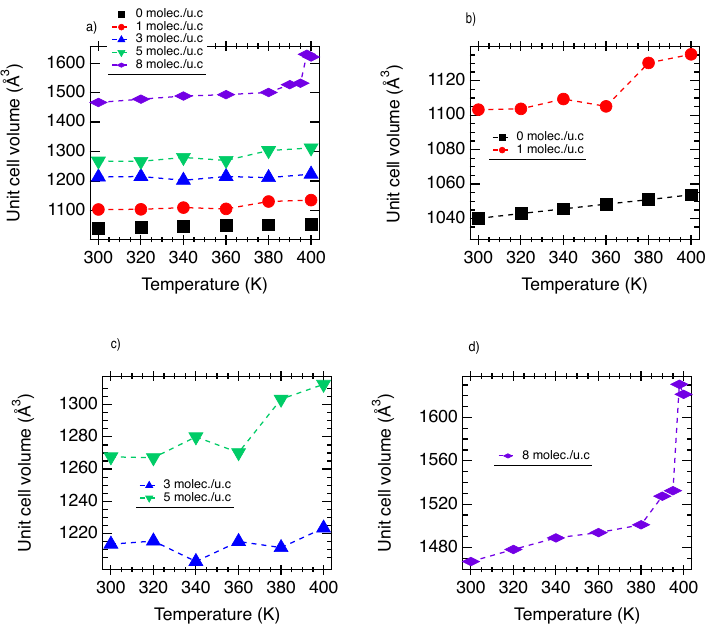
Figure 5. Scheme illustrating our protocol to evaluate the reopening of NH 2 -MIL-53(Al). molec./u.c., molecules by unit cell.